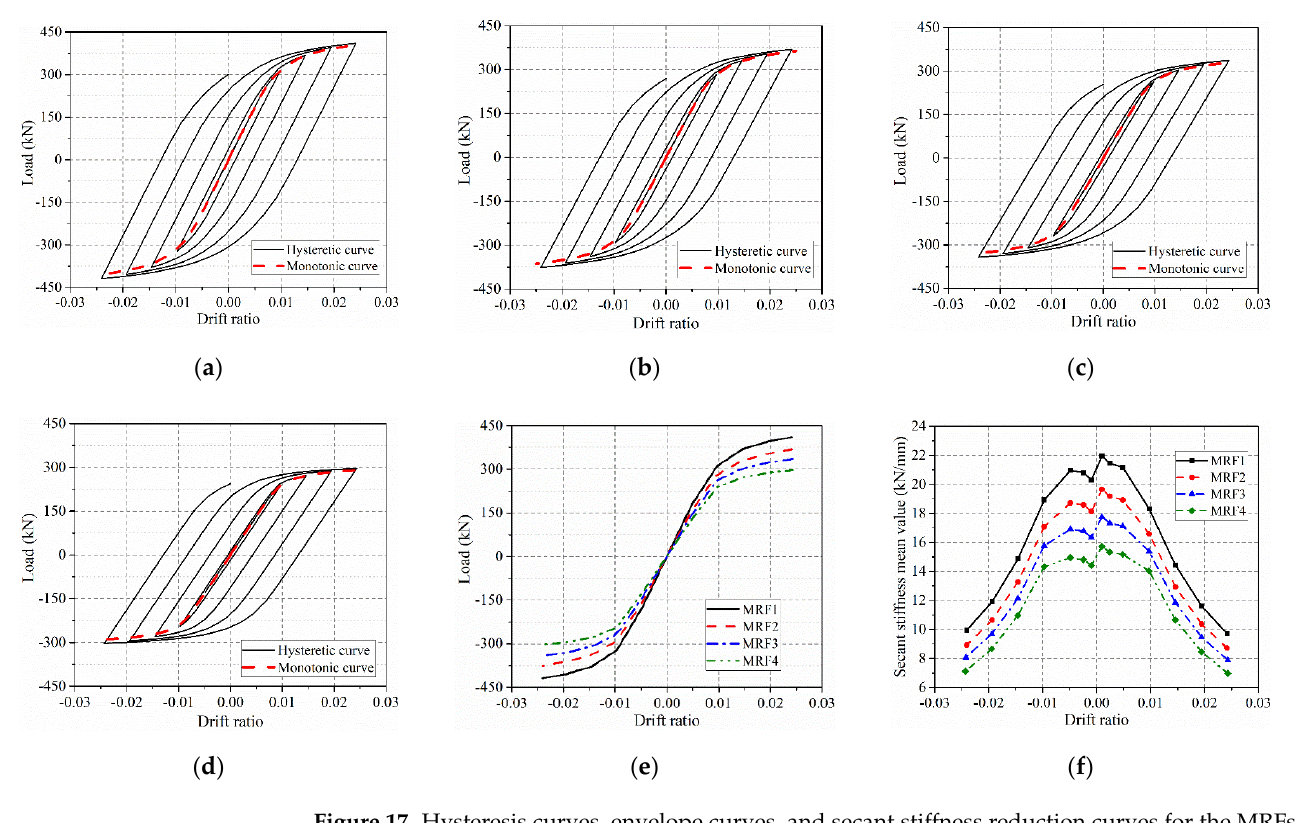
Figure 17. Hysteresis curves, envelope curves, and secant stiffness reduction curves for the MRFs with variable column flexural stiffnesses: ( a ) MRF1; ( b ) MRF2; ( c ) MRF3; ( d ) MRF4; ( e ) Envelope curves; ( f ) Secant stiffness reduction curves. Table 5. Analysis results for the MRFs, USPSWs, SPSW − 1VHS, SPSW − 3VHS, and SPSW − DS with various column flexural stiffnesses.